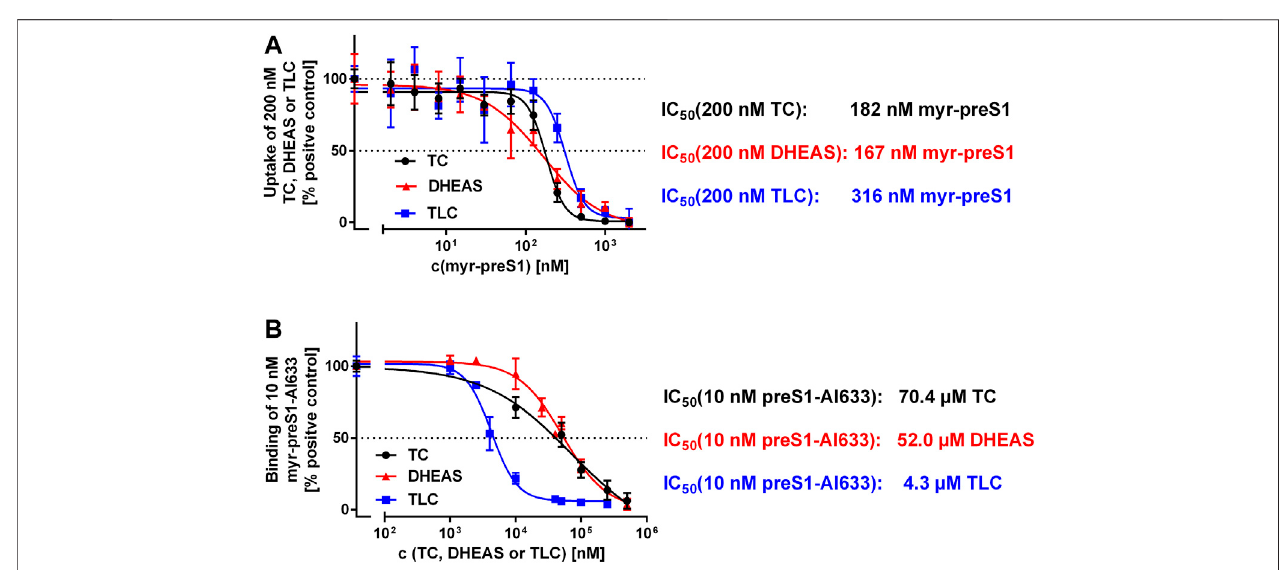
FIGURE 5 | Binding (A) and inhibition (B) of the myr-preS1 peptide at NTCP-HEK293 cells. (A) Transport of [ 3 H]TC, [ 3 H]DHEAS, and [ 3 H]TLC was analyzed in NTCP-HEK293cellsinthepresenceofincreasingconcentrationsofthemyr-preS1peptide.Transportrateswithoutmyr-preS1peptideweresetto100%.Graphsshow combined data of at least two independent experiments and represent means ± SD. (B) Binding of the fl uorescent myr-preS1-Al633 peptide was analyzed in NTCP- HEK293 cells in the presence of increasing concentrations of TC, DHEAS, or TLC. Graphs show combined data of at least two independent experiments and represent means ± SD. Fluorescence was quanti fi ed by a fl uorescence reader and values are expressed as percentage of control. IC 50 values were calculated by sigmoidal dose-response (variable slope) with a goodness of fi t ≥ 0.95 (GraphPad Prism software, version